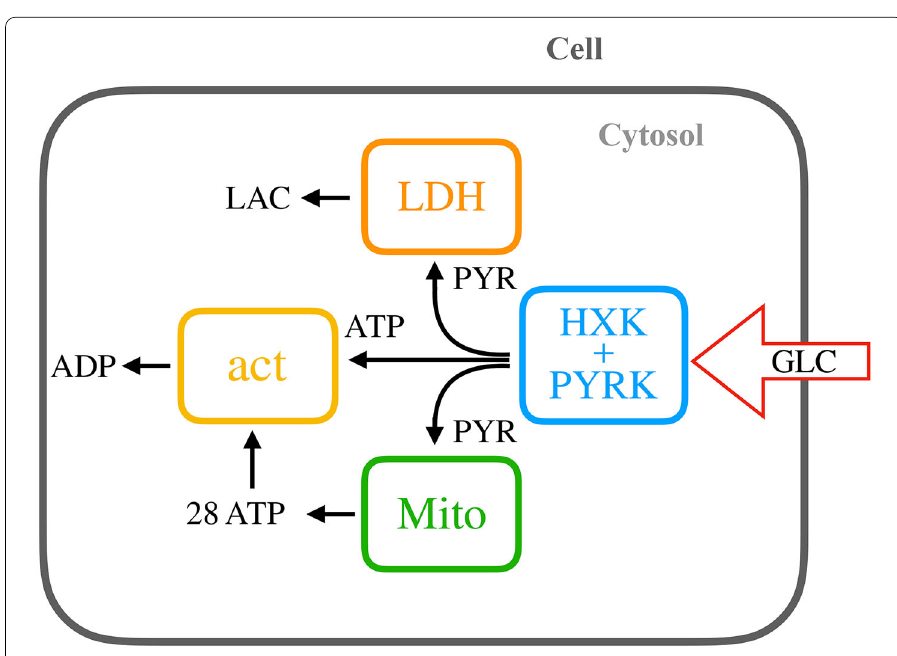
Fig. 3 The main pathways we consider in our Simplified Model of Energy Metabolism of a cell. The glucose (GLC) enters inside the cell into the cytosol and takes part into the glycolysis composed by the two reactions HXK and PYRK. The products of the glycolysis, PYR and ATP, are then used into LDH reaction, that generates LAC, into act reaction, that describes the cellular activity producing ADP, and inside the mitochondria where the reaction denoted Mito happens generating the major source of ATP for the cell